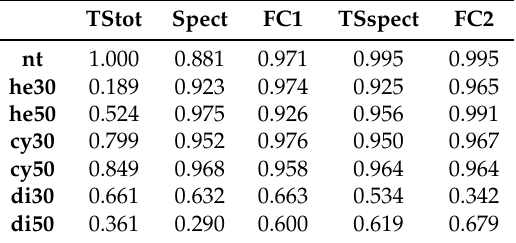
Table A2. Best ANNs’ F 1 score for wideband excitation (150kHz to 20kHz). Compare also Figure 7b.